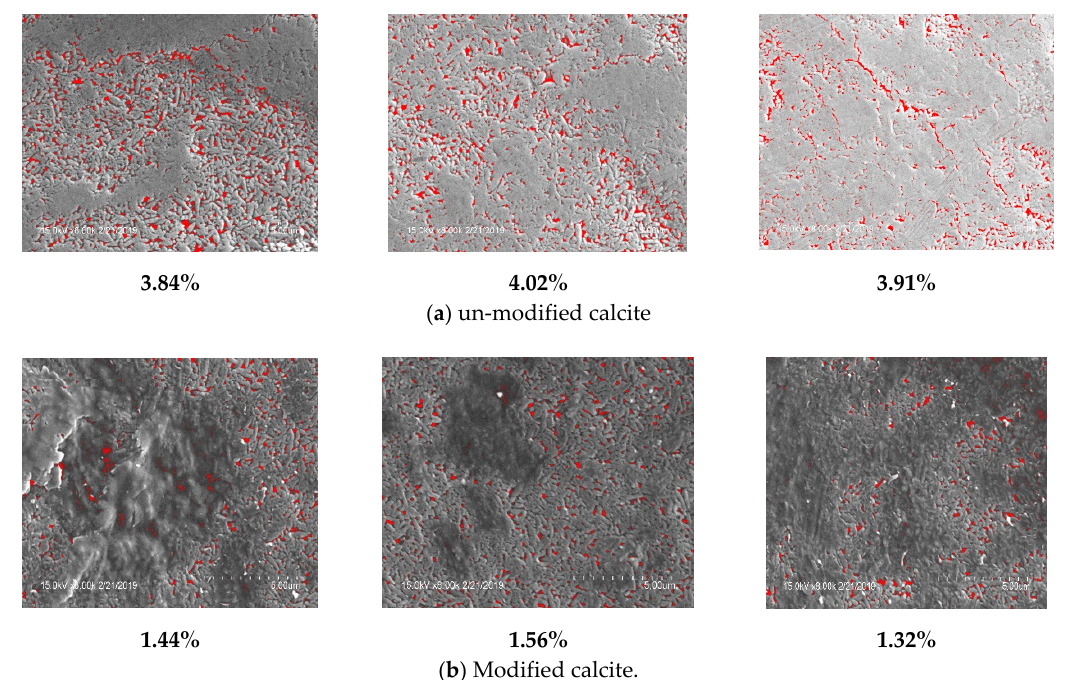
Figure 1. Calculated porosity of two sets of pelleted samples using 0.005 M stearic acid in n -decane: ( a ) un-modified samples; ( b ) modified samples.